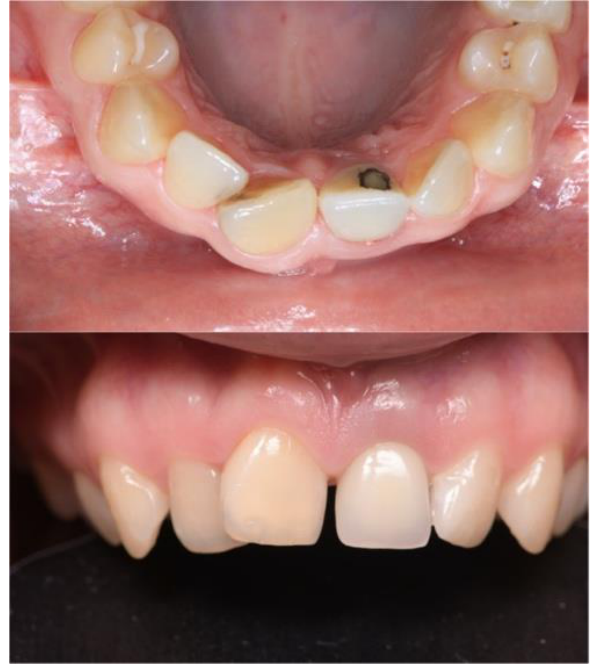
Figure 8. Temporary crown after immediate the implant surgery.